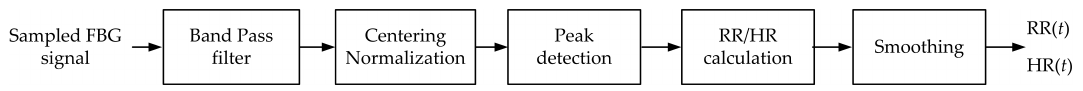
Figure 6. The signal processing from the FBG probe to determine the RR and the heart rate